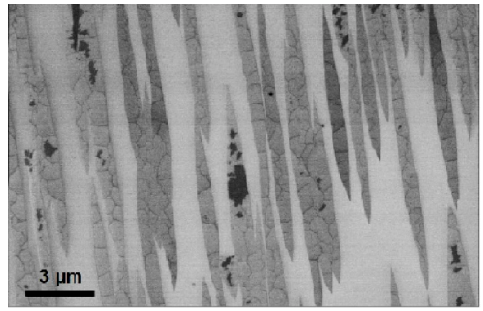
Figure 33. SEM image of ML graphene grown on 6H-SiC(1120) [143].